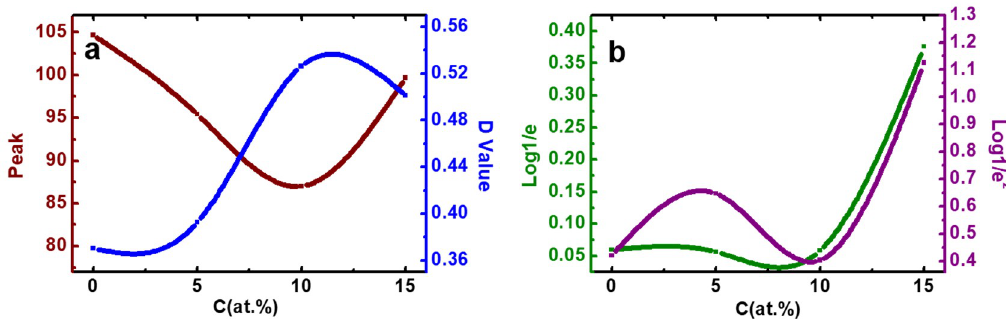
Figure 8. ( a ) Peak and D value changes with the Zr doping concentrations under 400 °C. ( b ) Log1/e and Log1/e 2 changes with the Zr doping concentrations under 400 °C.